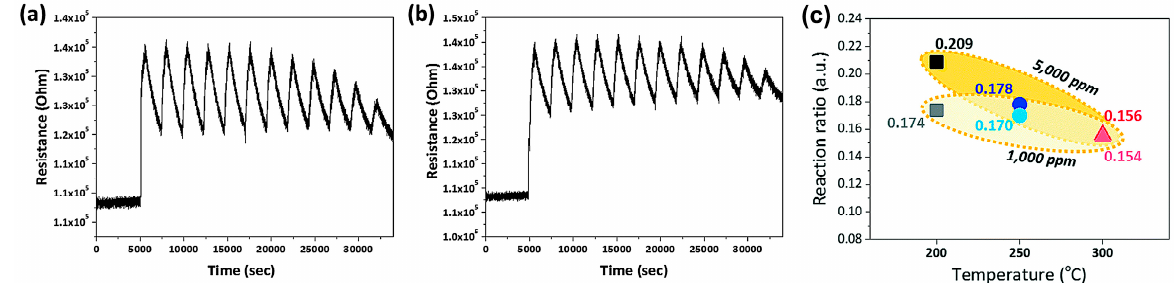
Figure 4. Performance of the CuO sensor: ( a ) The repeatability results for the CO gas-sensing response at 300 °C: run #1 and ( b ) run #2. ( c ) Reaction ratio for CO gas concentrations of 1000 and 5000 ppm. Reprinted with permission from Ref. [12]. Copyright 2019, The Royal Society of Chemistry.